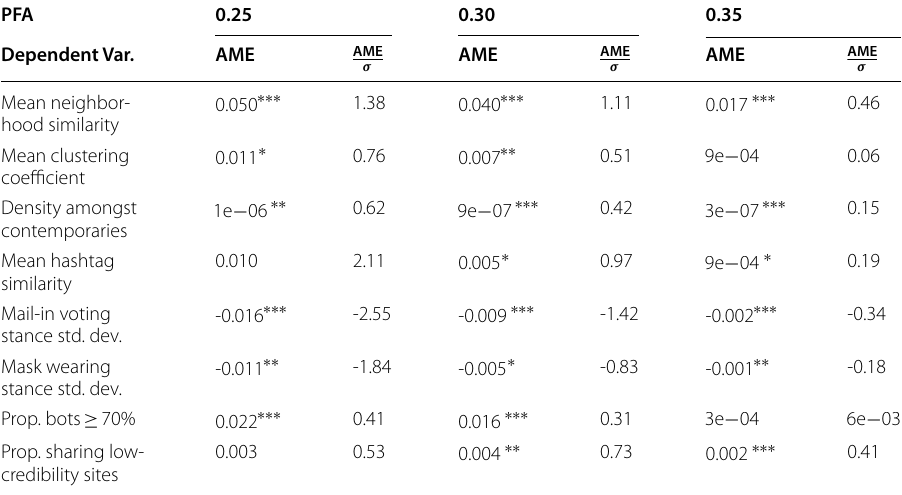
Table 1 The average marginal effects (AME) of the binary burst variable on each indicator of